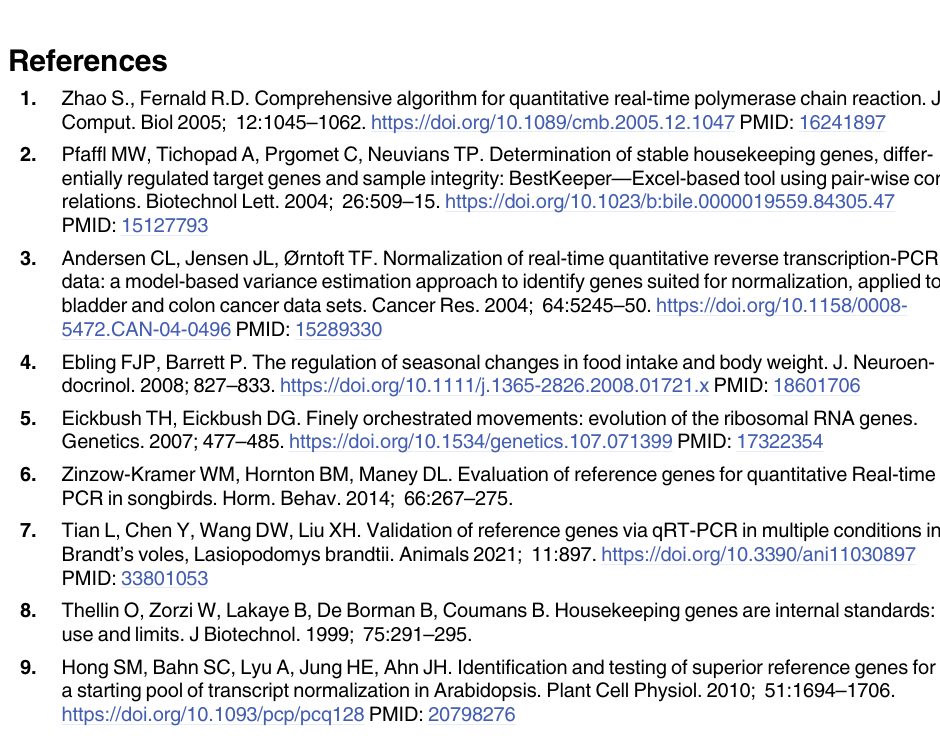
S1 Table. Raw data for reference transcript abundance, efficiency, variabiliy and stability across 8 Siberian hamster